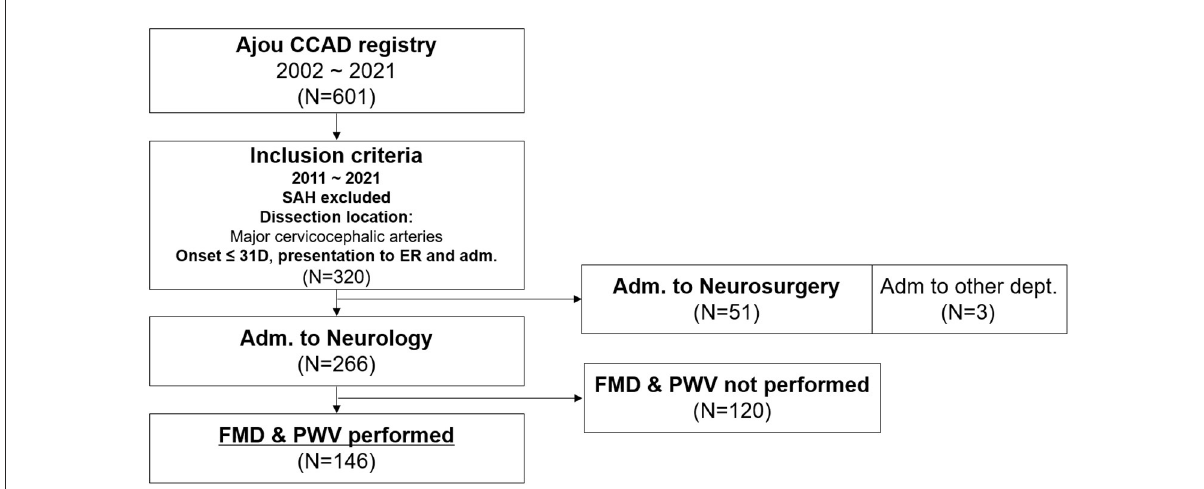
FIGURE1 Flowchart of patient inclusion for the current study. CCAD, cervicocephalic artery dissection; SAH, subarachnoid hemorrhage; ER, emergency room; FMD, flow-mediated dilation; PWV, pulse wave